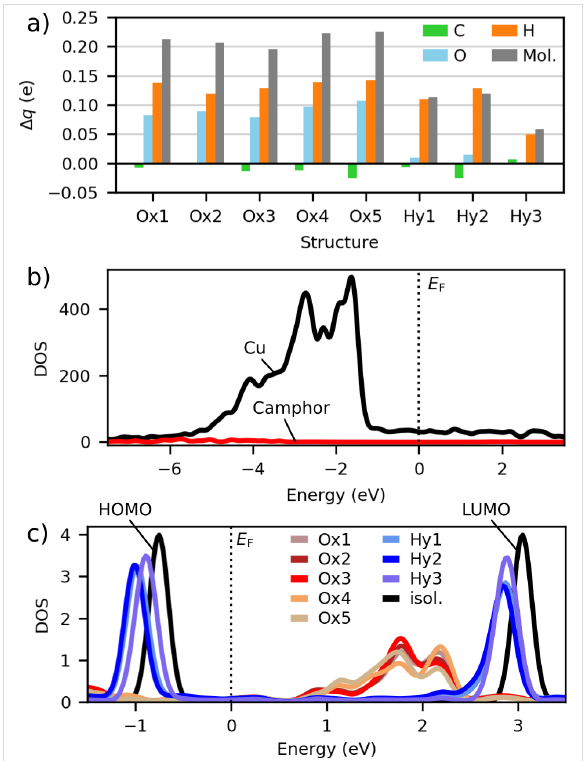
Figure 7: Electronic properties of different camphor adsorbates. (a) The sum of partial charges ( Δ q ) in the adsorbed camphor in the relaxed structures. (b) DOS of Cu and camphor in structure Ox1, and (c) DOS of camphor in the relaxed structures and in an isolated mole- cule.